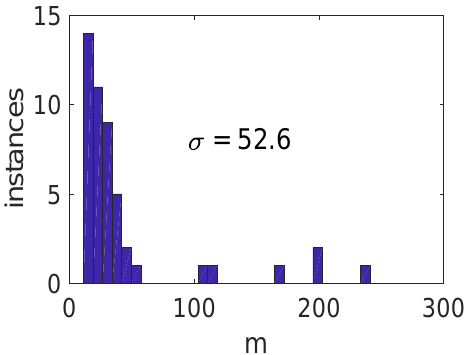
Figure 10. Inter-class PUF ( m ) distribution. Randomness of proposed PUF was measured on 16 devices (eight Xilinx Artix and eight Intel Cyclone V) with three PUFs each (48 instances).